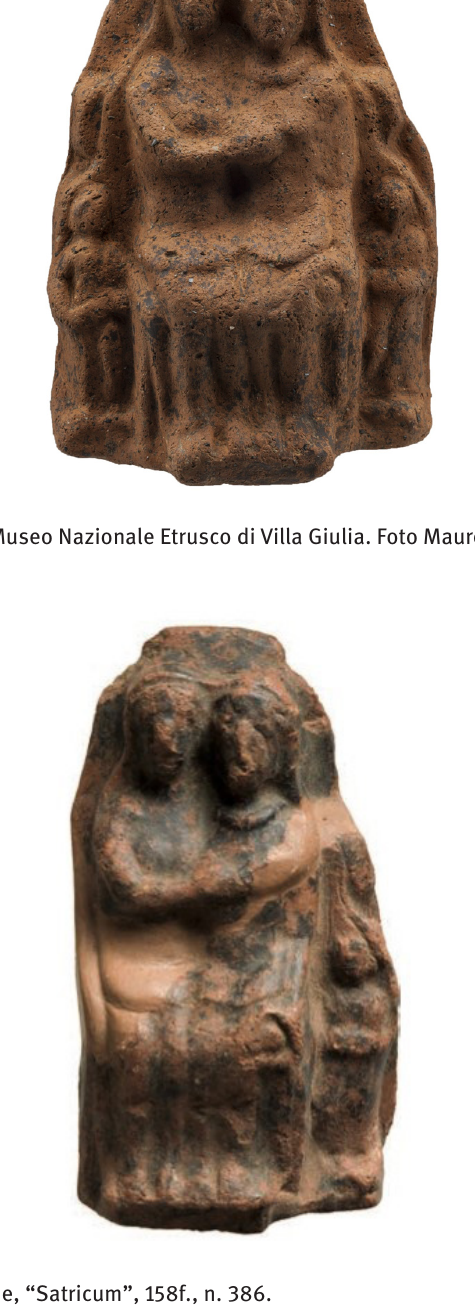
Figure 10. Satricum. From Gnade, “Satricum”, 158f., n.